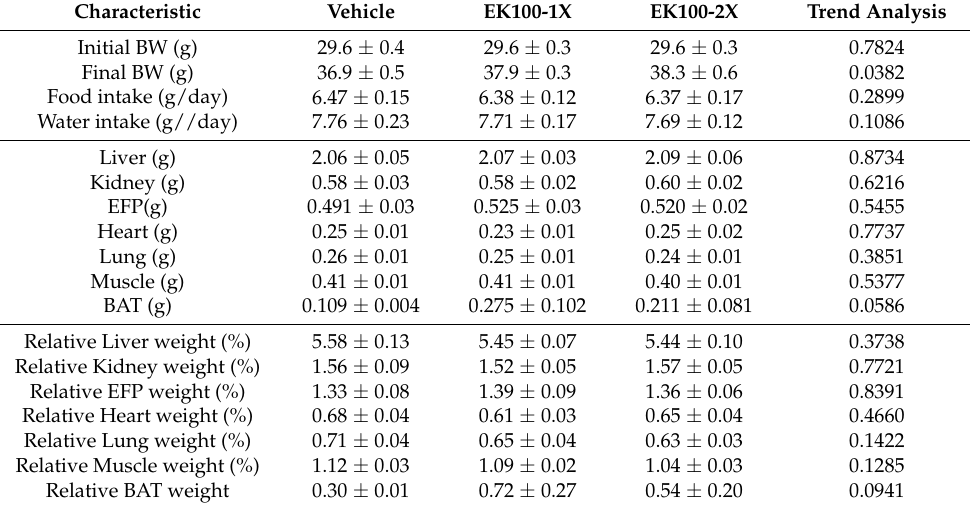
Table 1. General characteristics of mice with EK100 supplementation.